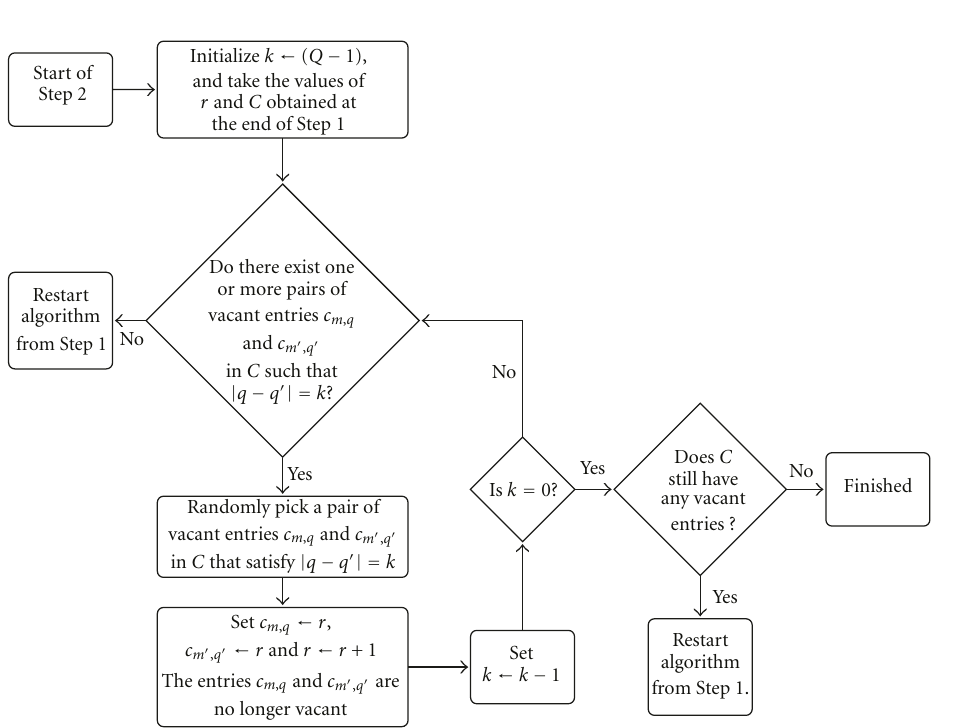
Figure 12: Step 2 of the